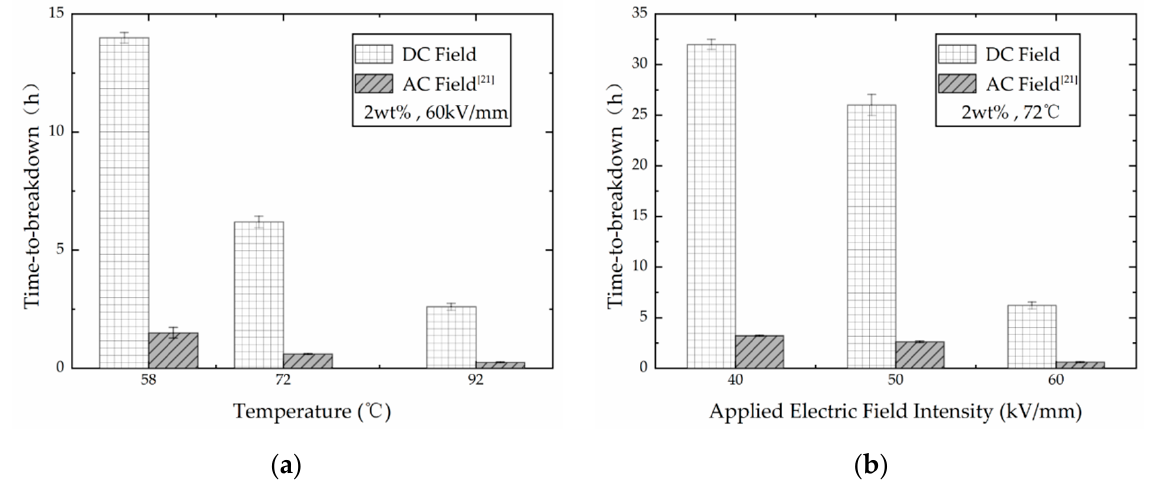
Figure 4. Results of PP film filled with 2 wt % nano-clay under DC and AC electric fields (data under AC electric fields are from [21]). ( a ) Results at 60 kV/mm; ( b ) results at 72 °C.